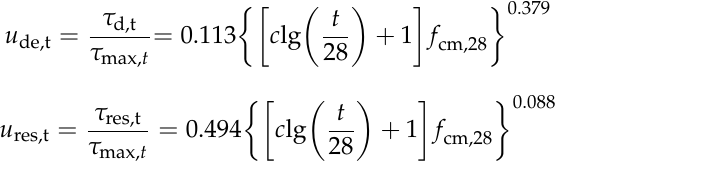
Table 5. Comparison results between calculated and test values of bond strengths. u de,t u res,t No. M40 M31 M24 M40 M31 M24